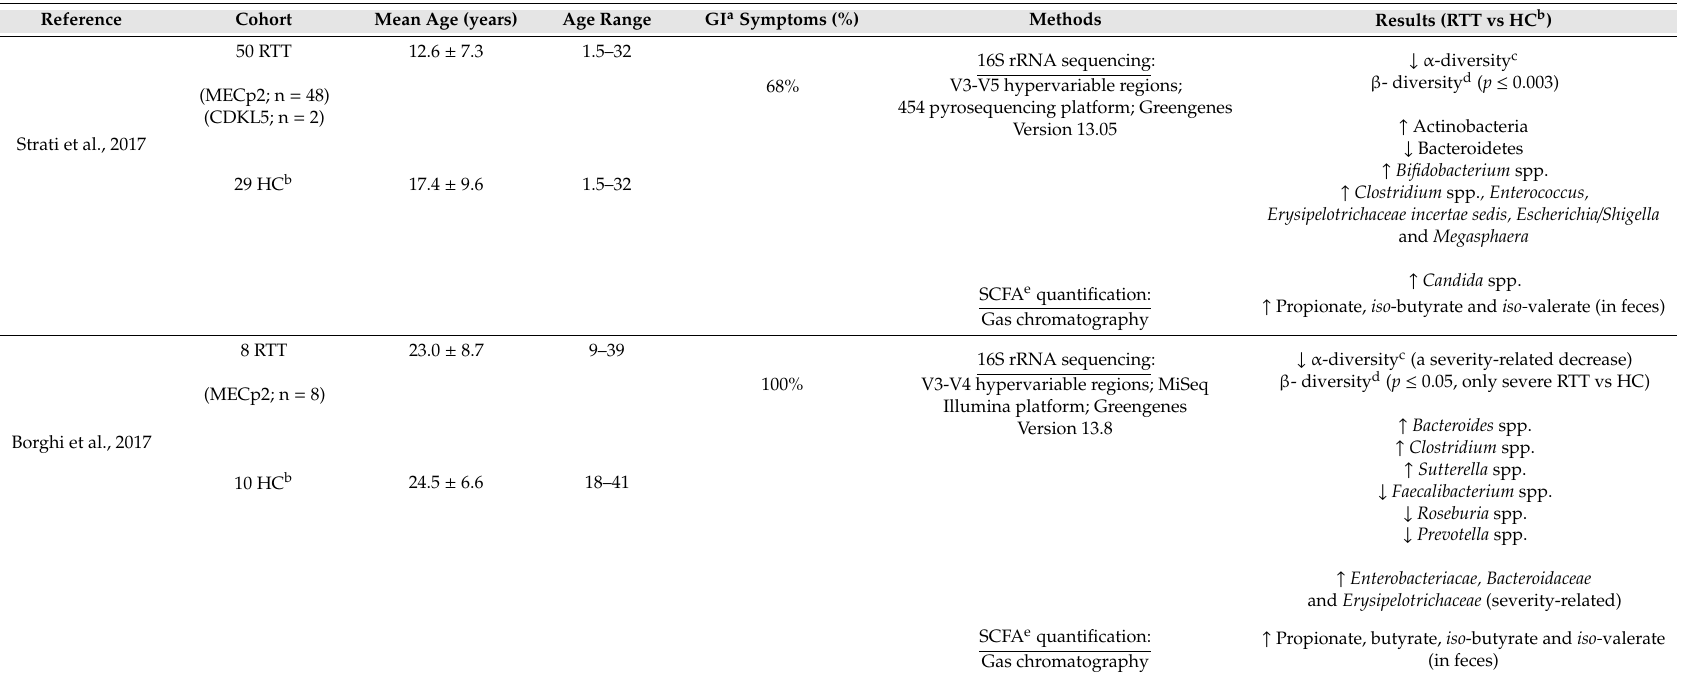
Table 1. Characteristics of gut microbiota studies in Rett syndrome